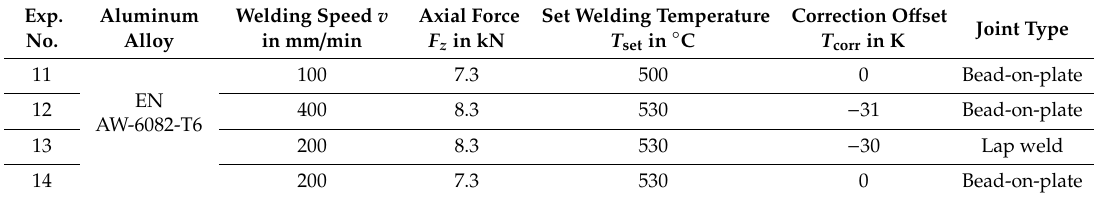
Table 2. Welding parameters of the experiments for the validation of the complete control